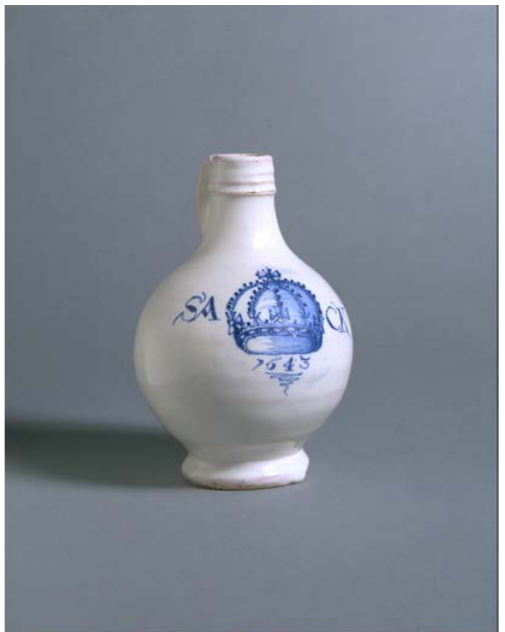
Figure 3 – Victoria and Albert Museum, London, museum no.